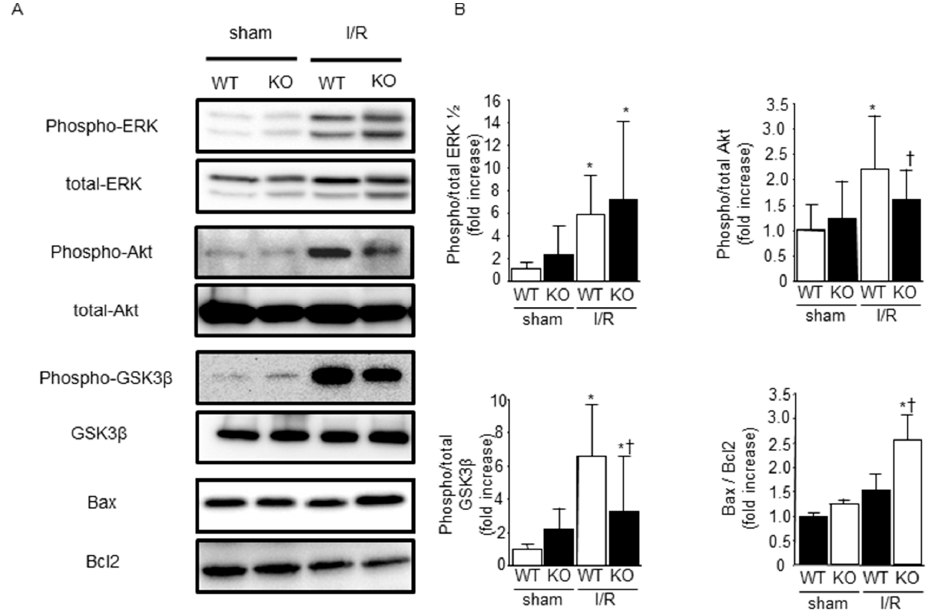
Figure 3. Effect of SMP30 deficiency on survival signaling proteins: ( A ) representative Western blots from WT and SMP30 KO mice subjected to 30 min of ischemia and 30 min of reperfusion; and ( B ) quantitative and statistical analyses of Western blots are shown. Data are represented as mean ± SE ( n = 8). ERK, extracellular regulated kinase, 1/2; GSK-3 β , glycogen synthase kinase-3 β . * p < 0.05 vs. sham-operated mice, and † p < 0.05 vs. WT I/R mice.